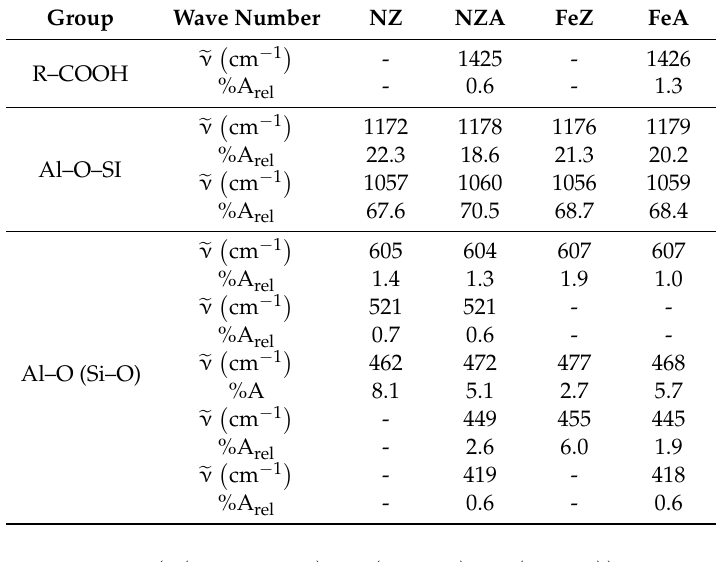
Table 3. Maximum absorption wavenumber (cid:101) ν (cm − 1 ) and relative area (%A rel ) obtained by deconvolution of the bands in spectral region 1500–400 cm − 1 .